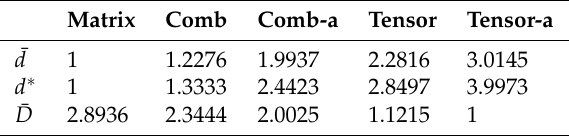
Table 12. Clustering metrics for each scheme (Source: Authors).